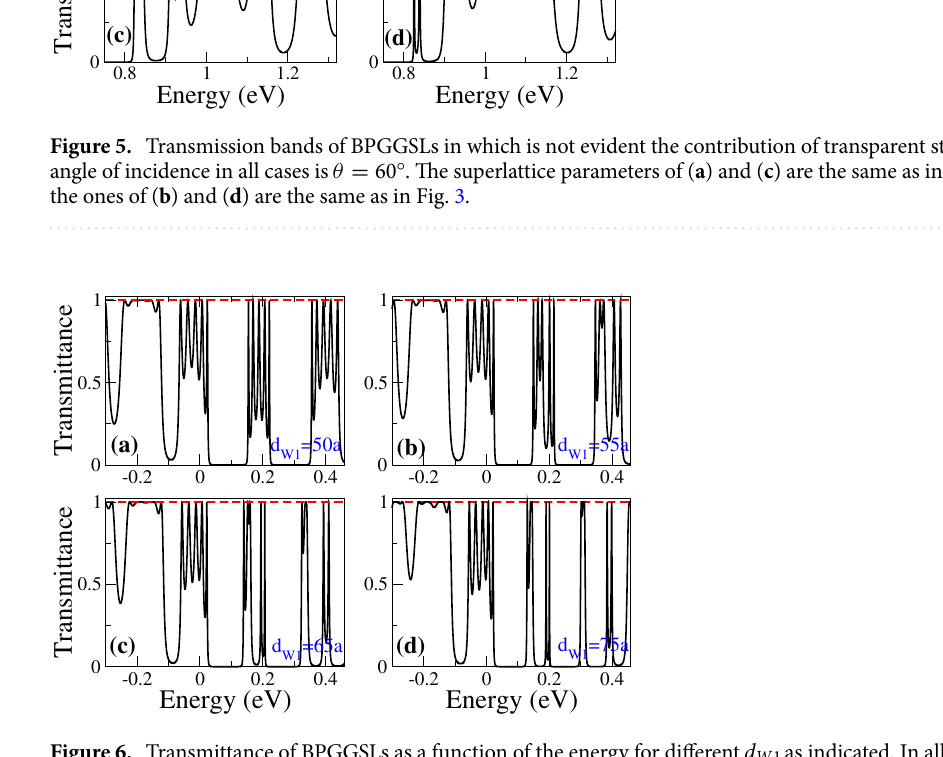
Figure 6. Transmittance of BPGGSLs as a function of the energy for different d W 1 as indicated. In all cases the other superlattices parameters are: θ = 45 ◦ , d W 2 = 50 a , V 0 = 0.1 eV and N = 3 .